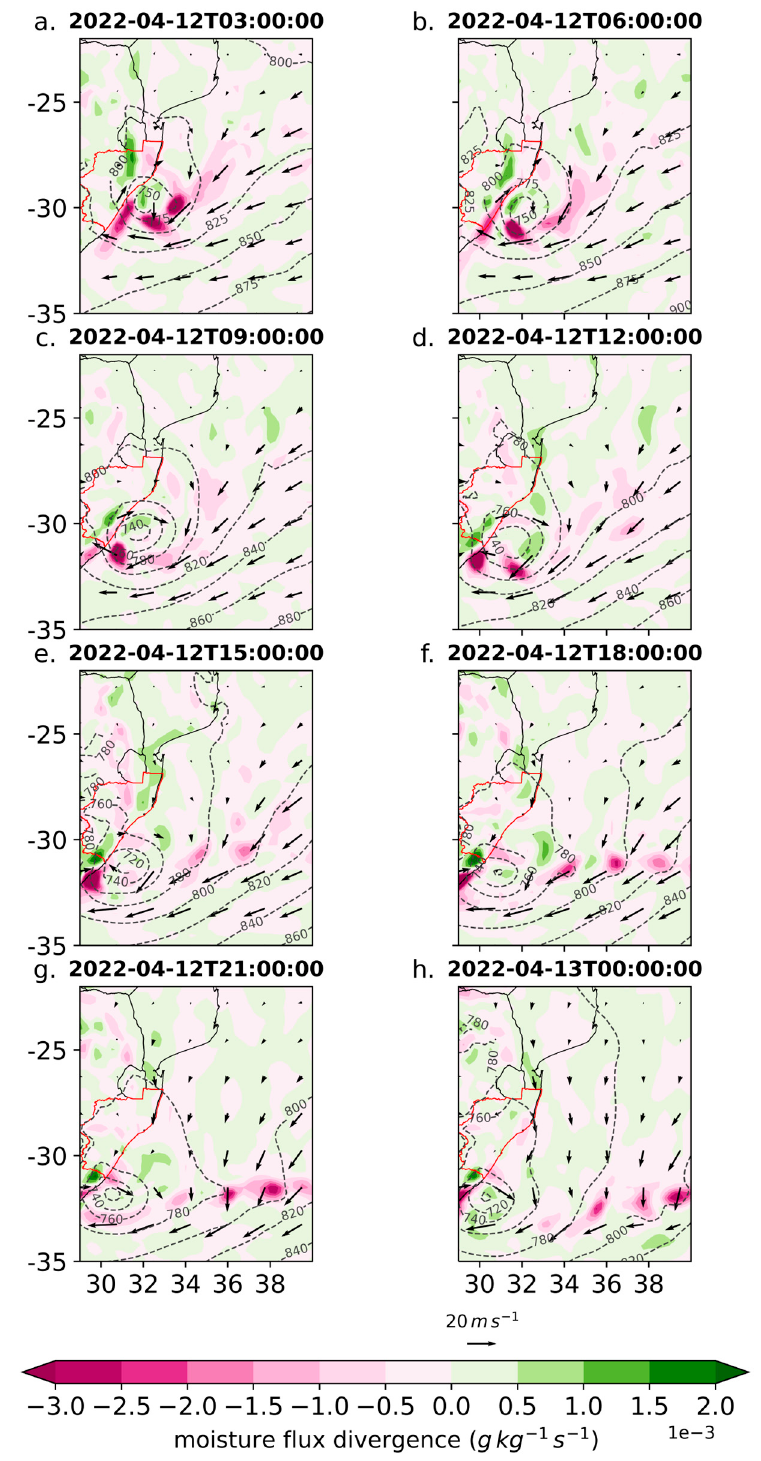
Figure A5. ERA5 moisture flux divergence (g kg − 1 s − 1 ) and wind speed (vectors; m.s − 1 ) at the 925 hPa pressure level at 3 h intervals at ( a ) 0300 UCT, ( b ) 0600 UTC, ( c ) 0900 UTC, ( d ) 1200 UTC, ( e ) 1500 UTC, ( f ) 1800 UTC, ( g ) 2100 UTC on 12 April 2022 through to ( h ) 0000 UCT on 13 April 2022.